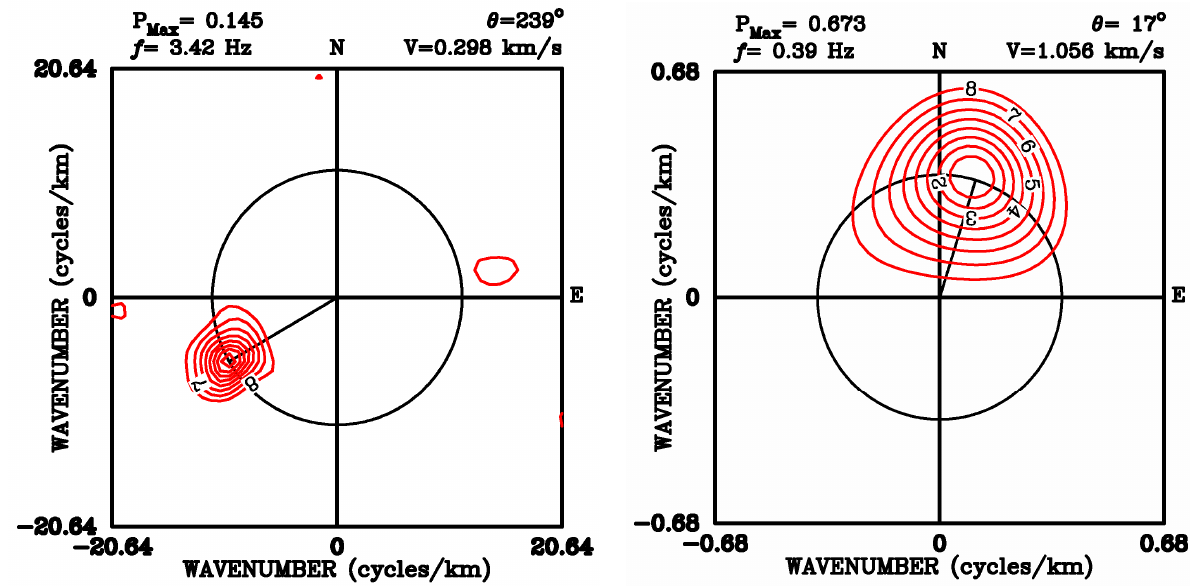
Figure 5. The f–k power spectra generated using the MLM method at the frequencies of 3.42 and Figure 5. The f – k power spectra generated using the MLM method at the frequencies of 3.42 and 0.39 Hz produced from the data of the S and L arrays at site DTE. 0.39 Hz produced from the data of the S and L arrays at site